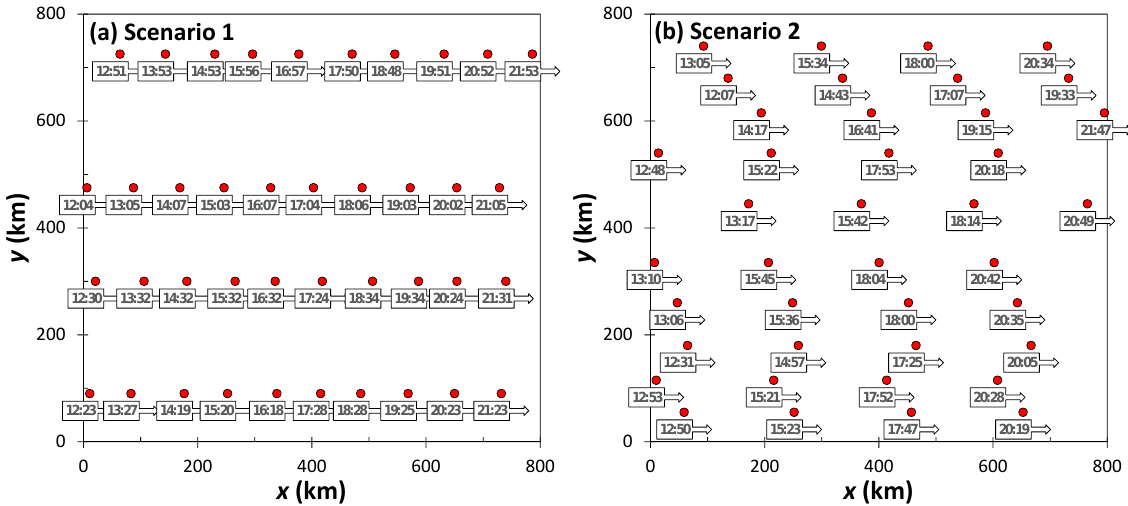
Figure 8. Two model scenarios for 40 tornadoes in an 800km × 800km region over a time period of 10h. (a) Four parallel supercells moving at about 80kmh − 1 with 10 tornadoes each. (b) Ten parallel supercells moving at about 80kmh − 1 with four tornadoes each.